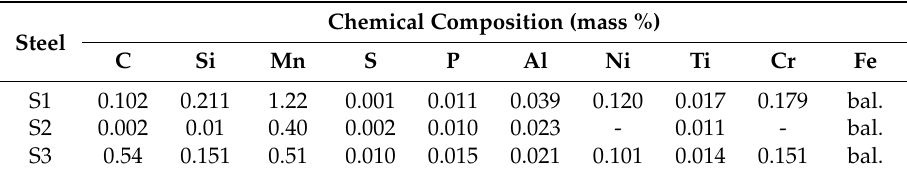
Table 1. Chemical composition of steel